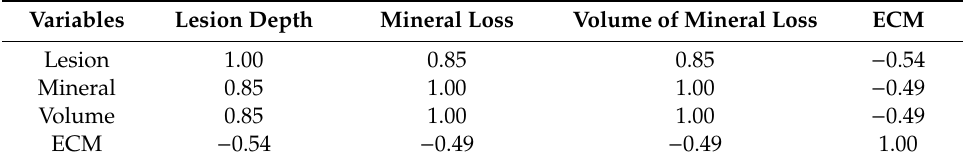
Table 5. Correlation of ECM with microradiography data of dentine (Pearson’s Correlation test). Variables Lesion Depth Mineral Loss Volume of Mineral Loss ECM Lesion 1.00 0.85 0.85 − 0.54 Mineral 0.85 1.00 1.00 − 0.49 Volume 0.85 1.00 1.00 − 0.49 ECM − 0.54 − 0.49 − 0.49